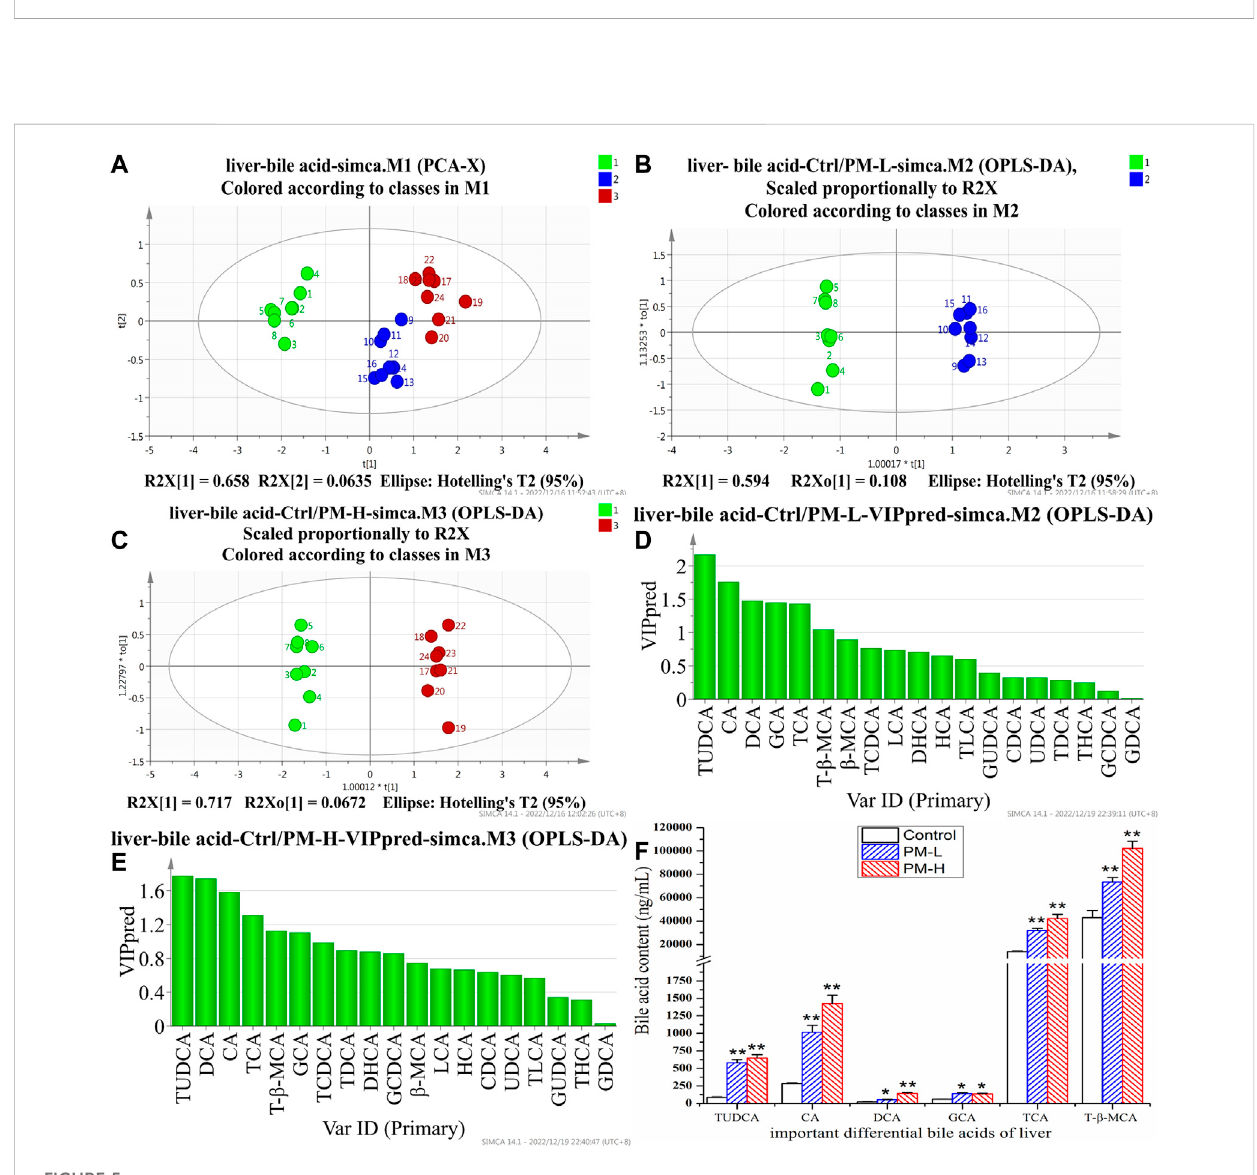
FIGURE 5 Score chart of PCA analysis of 19 bile acids in liver (A) ; score chart and VIP values of OPLS-DA analysis of 19 bile acids in liver (B – E) ; The screened important differential bile acids and their contents (F) . (X± SEM, n = 8, * p < 0.05, ** p <